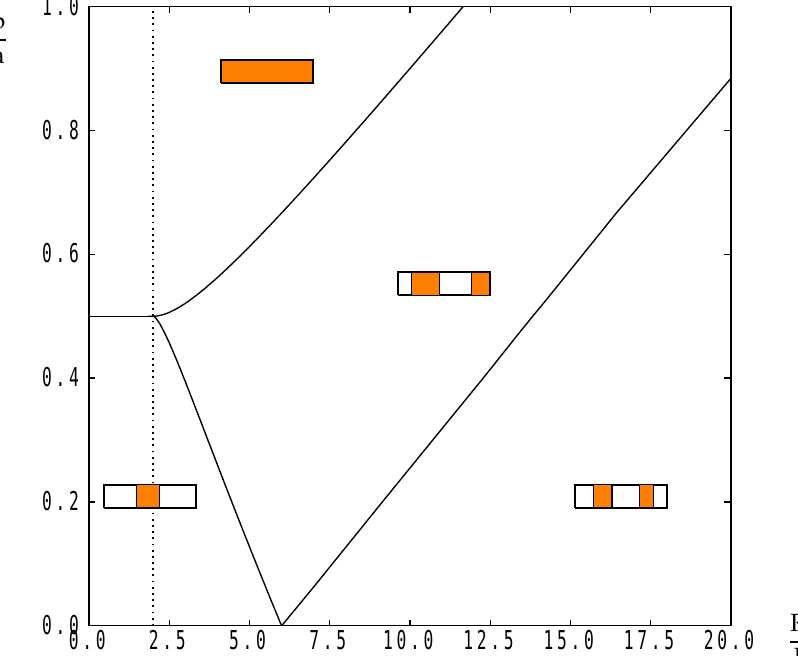
Figure 5. The loci of points in parameter space which delineate the various cases where the fluid flows and where it is stagnant. The different patterns of flow and stagnation are depicted by the insets. The region to the right of the dotted line corresponds to when θ displays an internal maximum value, while the region on the left corresponds to when the maximum is at x = 1.